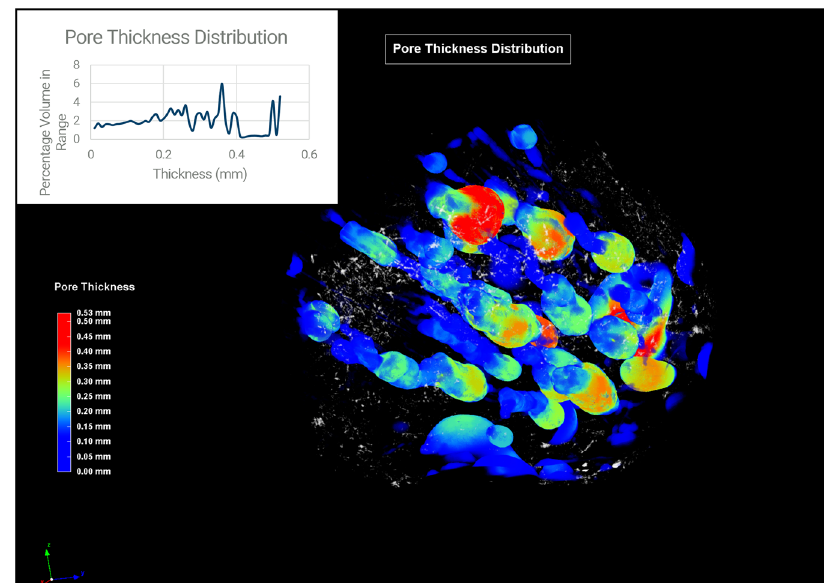
Fig. 3 Nanotomography of the iron silicide spherule. The scan in one fi eld of view allows to visualize the color-coded 3D thickness distribution of the pore network inside the sample. The thickness distribution plot of the analysis is shown in the